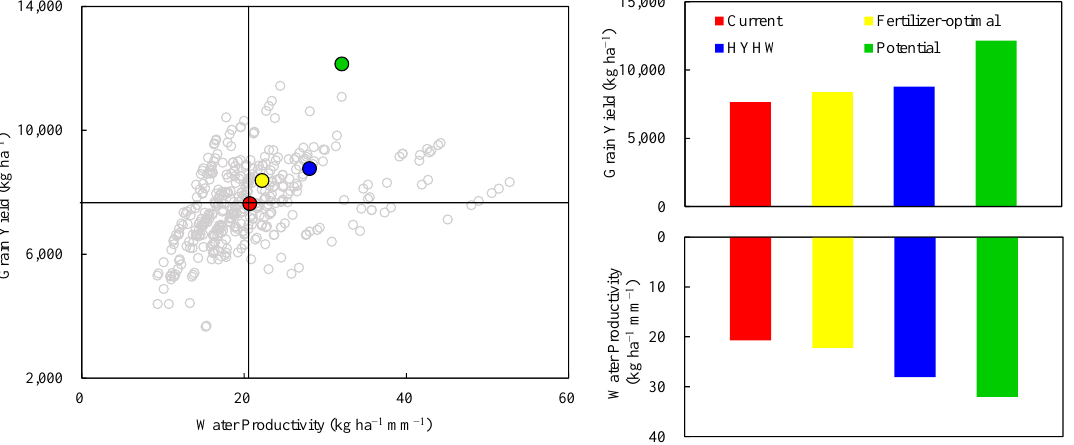
Figure 4. Scenario analyses and the possible strategies to improve the yield and WP.